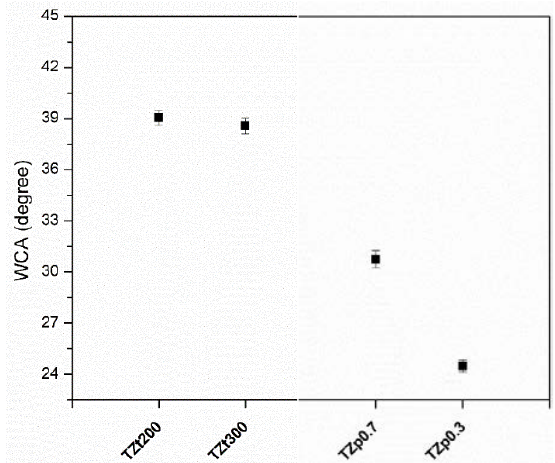
Figure 7. Sessile drop water contact angle measurements performed on the surfaces of the TZO films after annealing: at 200 °C (TZt200), at 300 °C (TZt300), with MwPA at 0.3 mbar (TZp0.3) and with MwPA at 0.7 mbar (TZp0.7).